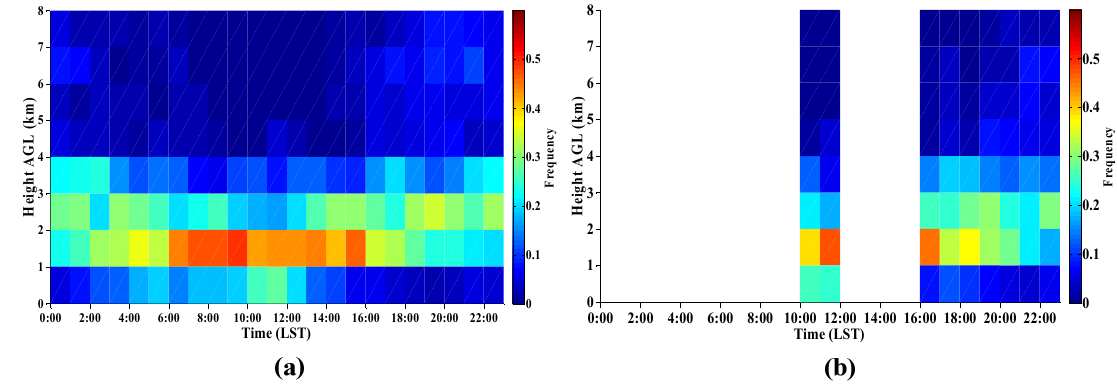
Figure 12. Averaged diurnal variation of CBH spatial distribution measured by: ( a ) CL31; and ( b ) WACAL during measurement period.